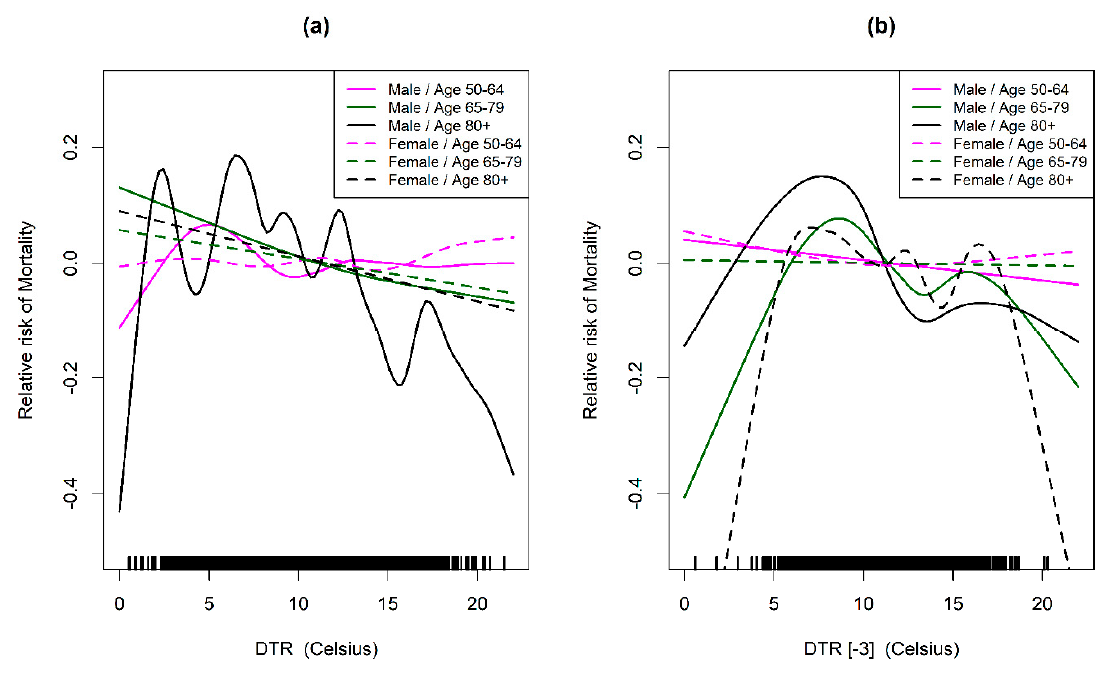
Figure 4. Mortality relative risk functions for Nicosia, Cyprus, 2007-2014 with ( a ) DTR of the same day, ( b ) Weighted average DTR of the preceding three days (DTR [ – 3] ).